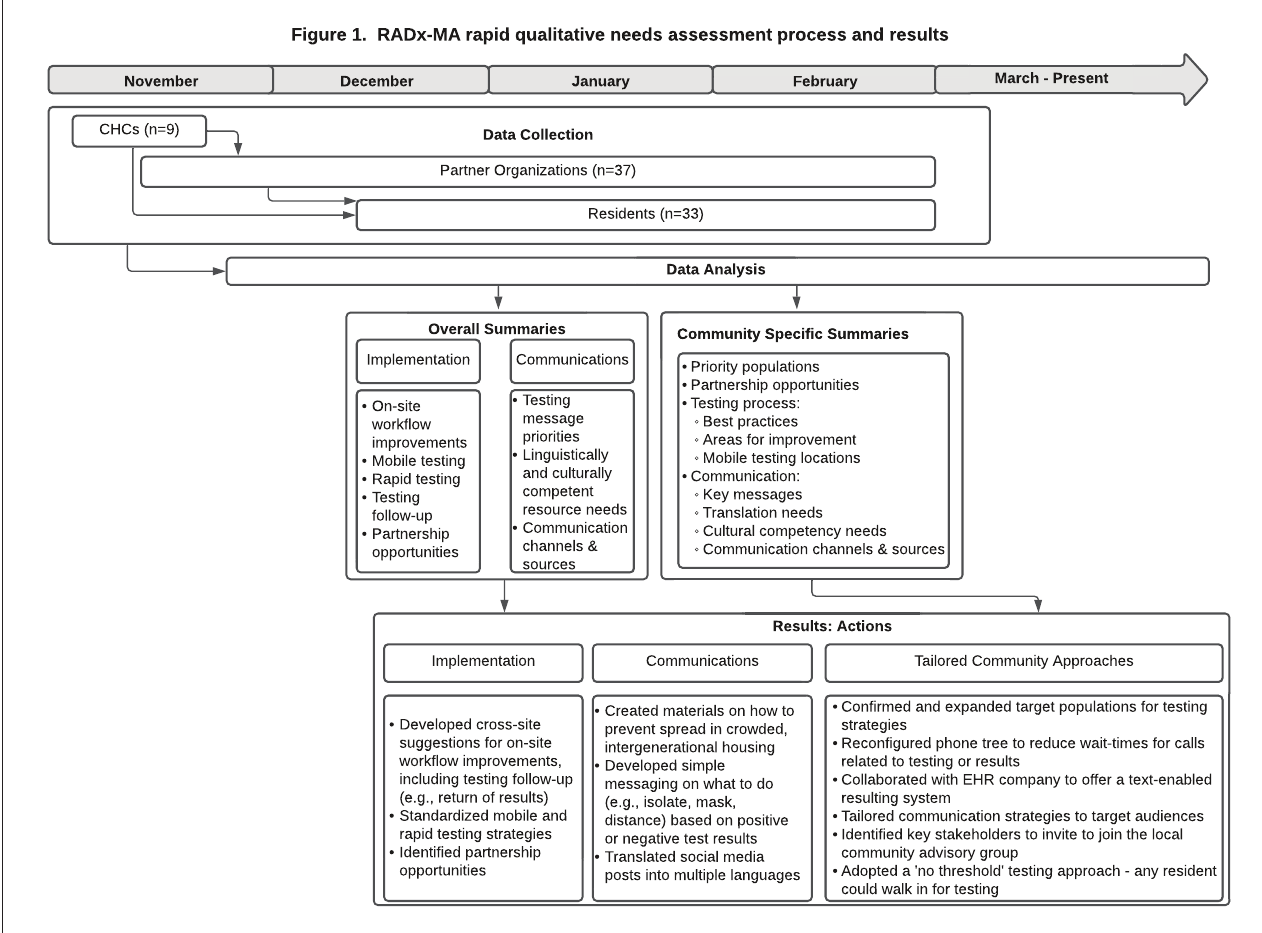
FIGURE 1 | RADx-MA rapid qualitative needs assessment process and